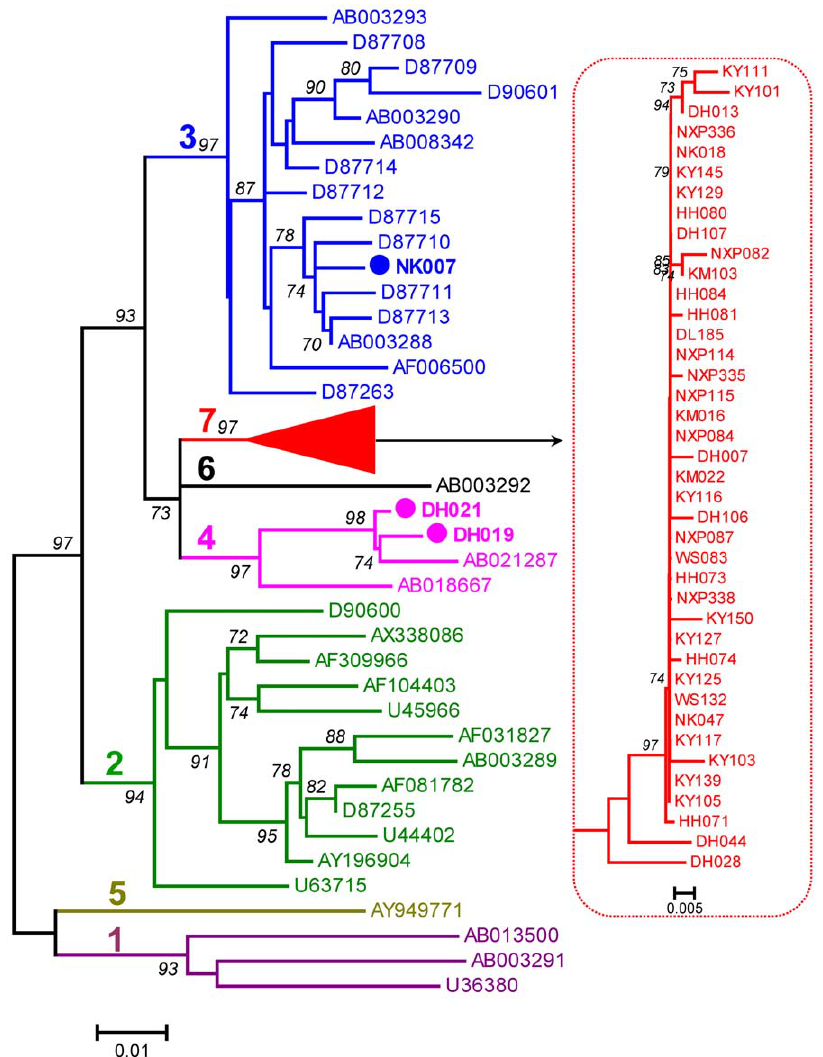
Figure 2. Phylogenetic tree based on 5 9 UTR sequences of 378 nt in length. The sequences corresponding to nucleotide positions -210 to 148 in the genome of prototype GBV-C isolate U36380. The known six GBV-C genotypes are indicated with number 1–6. Reference GBV-C sequences is indicated with isolate names followed by their Genbank accession numbers. The neighbor-joining tree was constructed using the Jukes-Cantor distances. Bootstrap values are shown in bold.